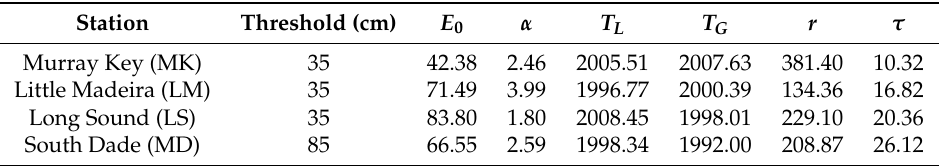
Figure 10. Yearly water level elevation exceedance data and fits to the model of Equation (1). Elevation thresholds are with respect to the NGVD29 datum. Note that the MD station is located on a higher land elevation than the other three stations. ( a ) MK; ( b ) LM; ( c ) LS; ( d ) MD. Table 4. Exceedance model parameters at an elevation threshold of 35 cm NGVD29 at Murray Key (MK), Little Madeira Bay (LM) and Long Sound (LS). Note that the South Dade (MD) station is located on a higher land elevation and uses a threshold of 85 cm